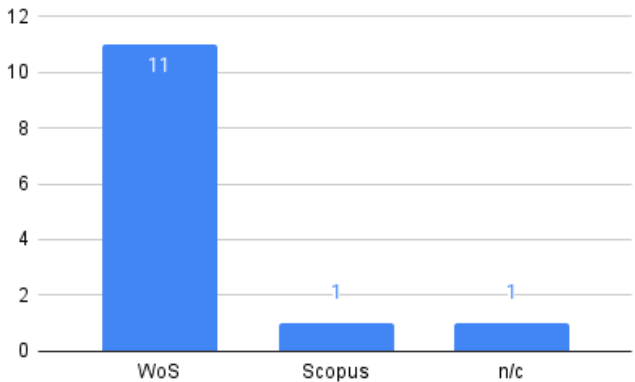
Figure 16. Journals according to their indexing.